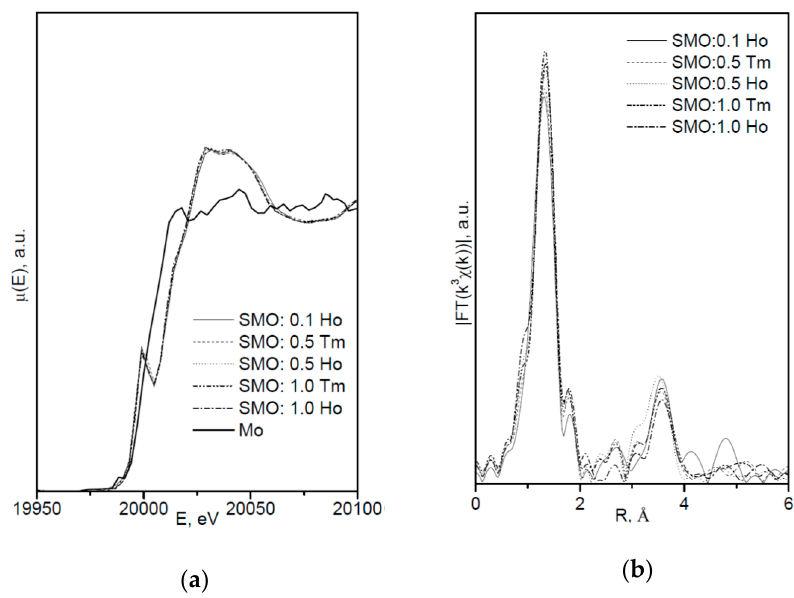
Figure 2. Mo K-edge-normalized ( a ) X-ray absorption spectroscopy (XANES) spectra and ( b ) EXAFS Fourier transforms for SrMoO 4 :Ho and SrMoO 4 :Tm crystals. The standard is metal molybdenum.